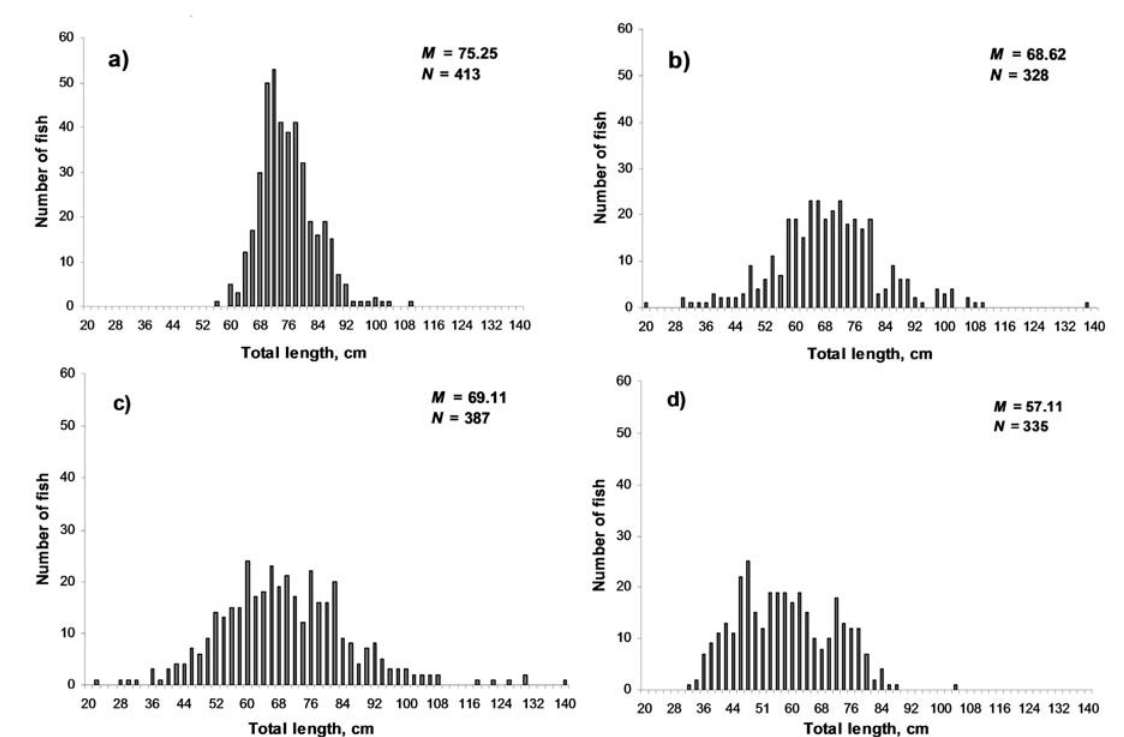
Fig . 7. – Size composition of Squalus suckleyi in the catches of (a) salmon driftnets in the Pacific off the Kuril Islands and Kamchatka, (b) pelagic trawls in the North Pacific, (c) bottom trawls in the northwestern Pacific, and (d) bottom trawls in the northeastern Pacific ( M , mean length, cm; N , number of fish measured).